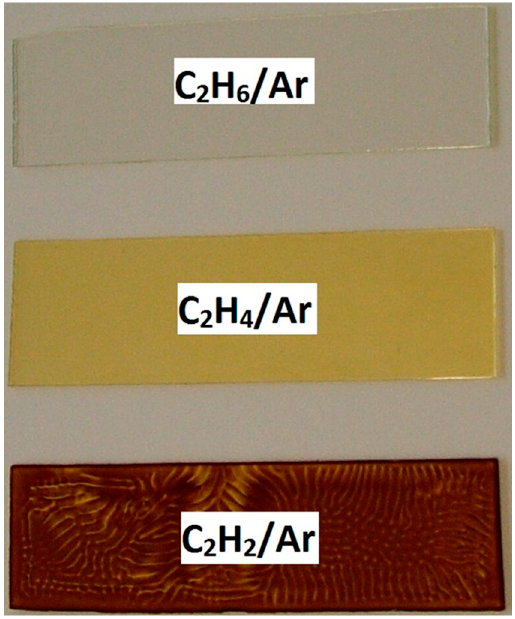
Figure 1. Photographs of a-C:H films deposited on glass substrates in a dielectric barrier discharge (DBD) with different precursor gases C 2 H m /Ar ( m = 2, 4, 6).